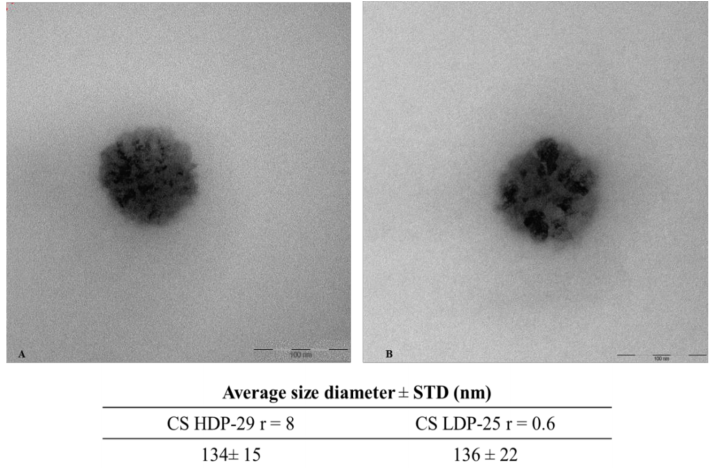
Figure 5. Representative TEM images of complexes containing: ( A ) CS HDP-29 N/P = 8; and ( B ) CS LDP-25 N/P = 0.6 stained with uranyl acetate. The embedded table shows the measured diameter of the complexes using ImageJ v1.49n ( n = 8; mean average ± SD). Source Santos-Carballal et